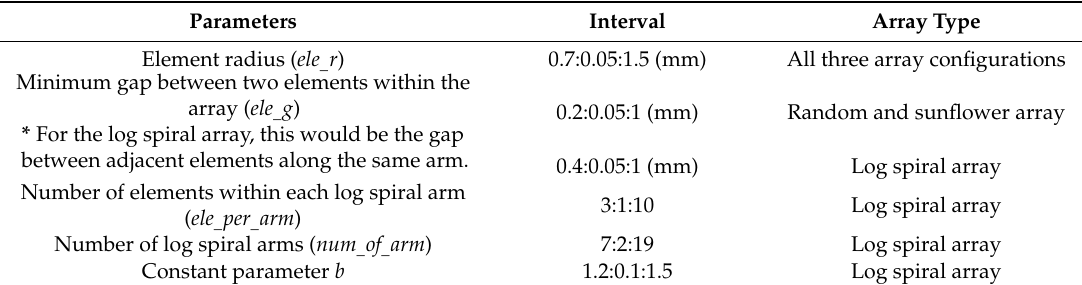
Table 1. Parameters and candidate values for each array